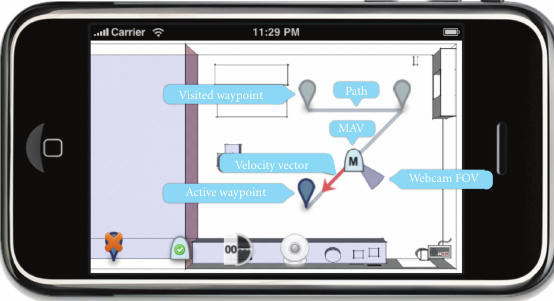
Figure 2: Details of the MAV-VUE map display.